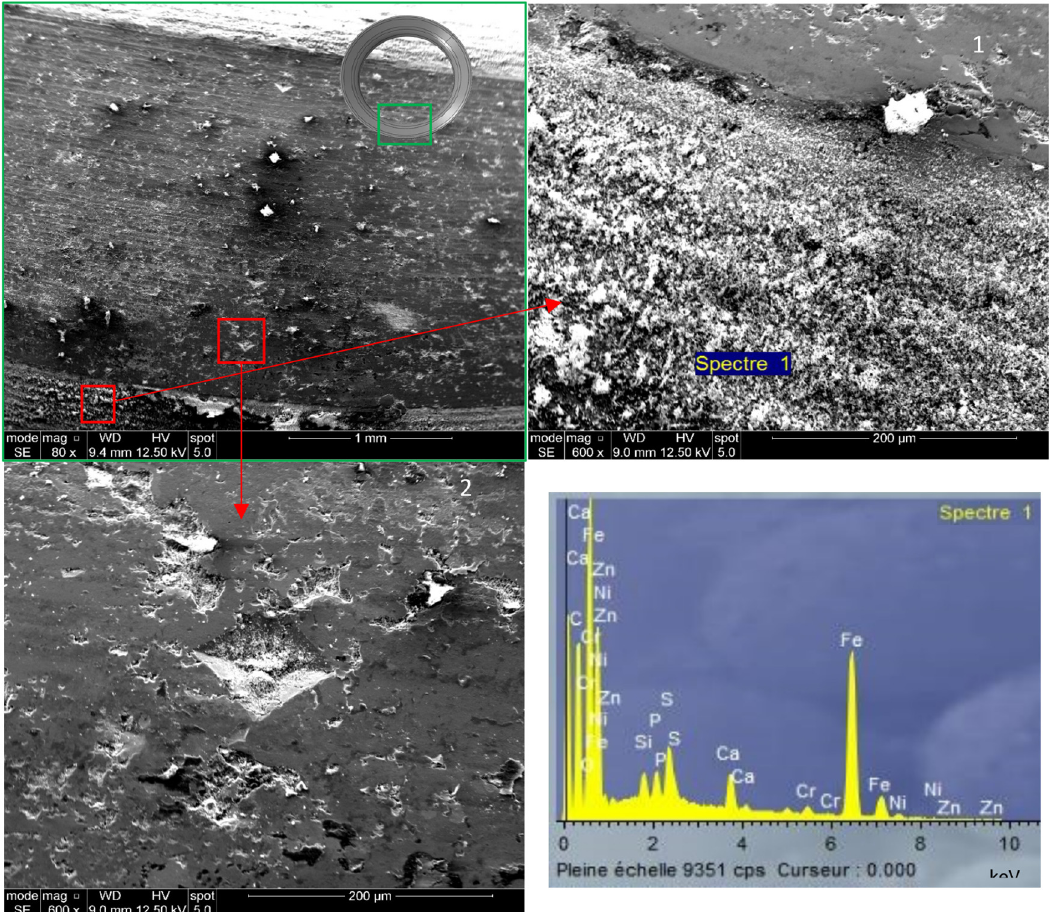
Fig. 31. Oil impregnation, of the seat porosities, 4 hours of testing on the “ Cube ” , (1) Bottom of the contact area with burnt oil, (2) indentation in the contact